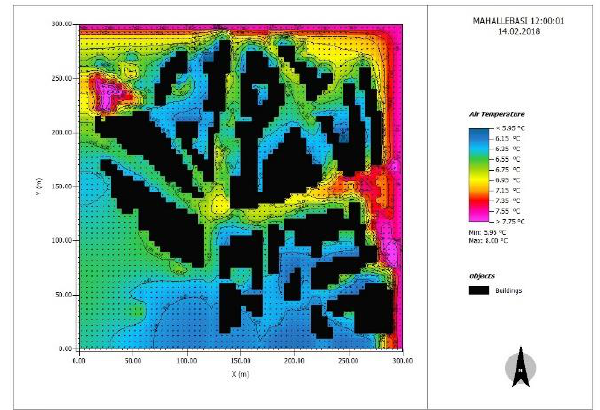
Figure 5. ENVI-met Simulation for